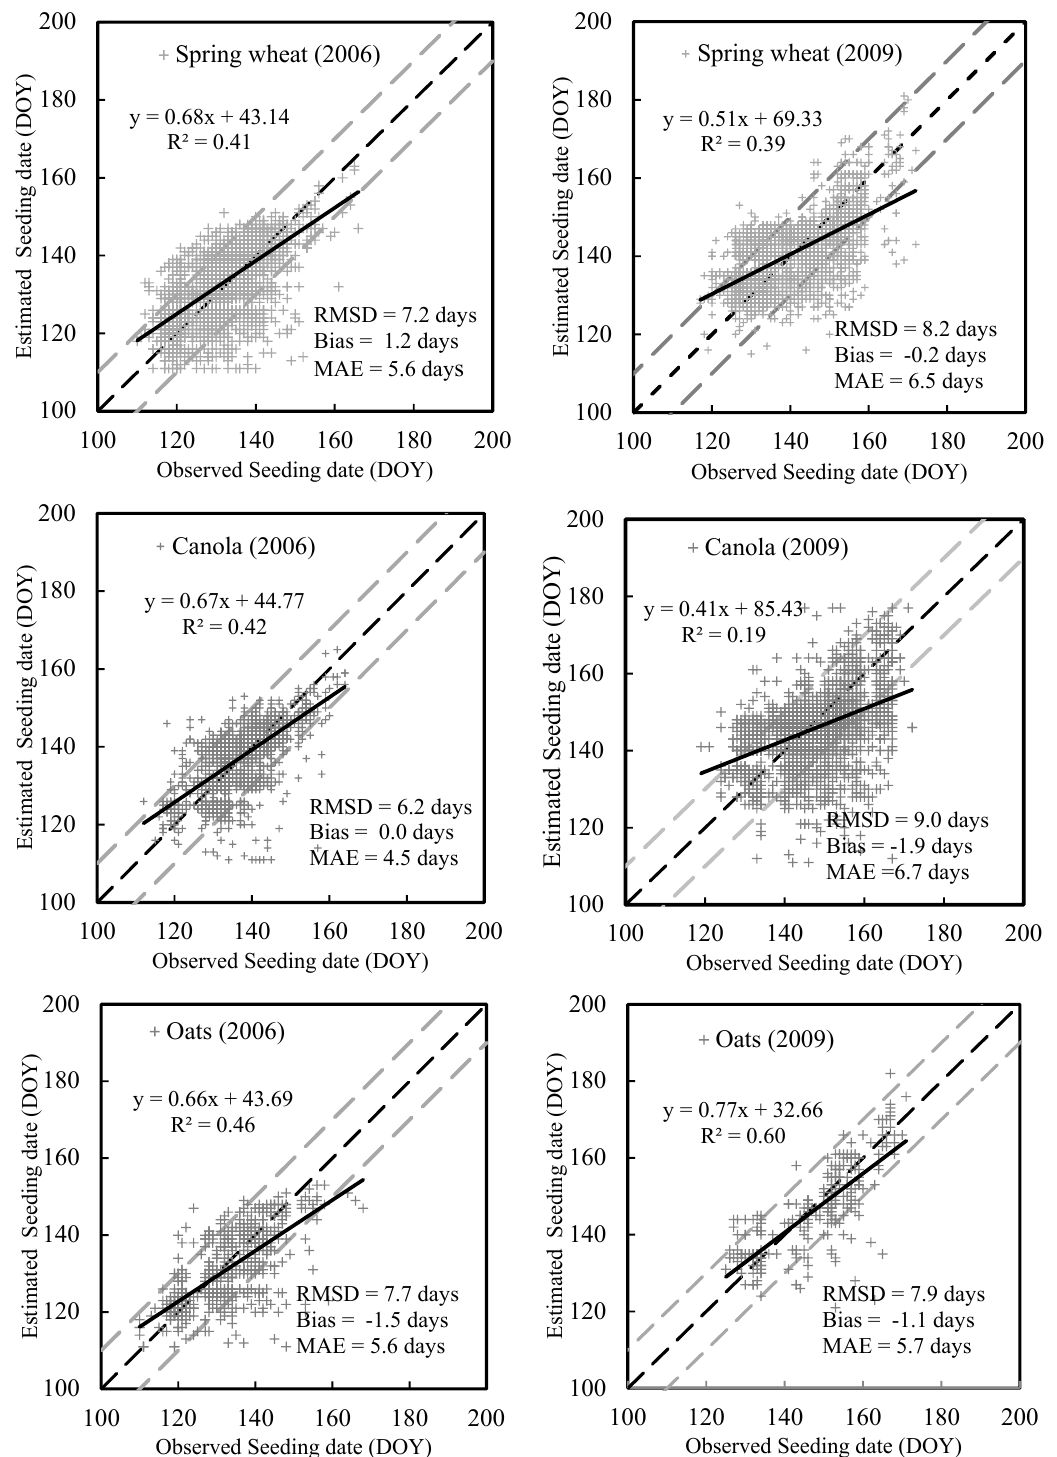
Figure 7. Comparison between observed and estimated seeding date using the inflection based approach (SOS inflection) ; the dashed gray lines mark is the 10-day confidence interval, and the dashed black line denotes the 1:1 lines.